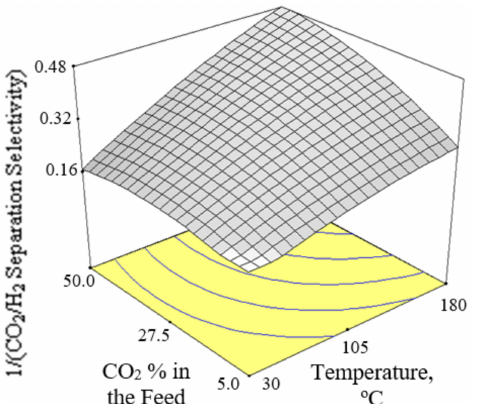
Figure 8. Effect of interaction between CO 2 % in the feed and temperature on the 1/(CO 2 /H 2 separation selectivity) at 300 kPa pressure